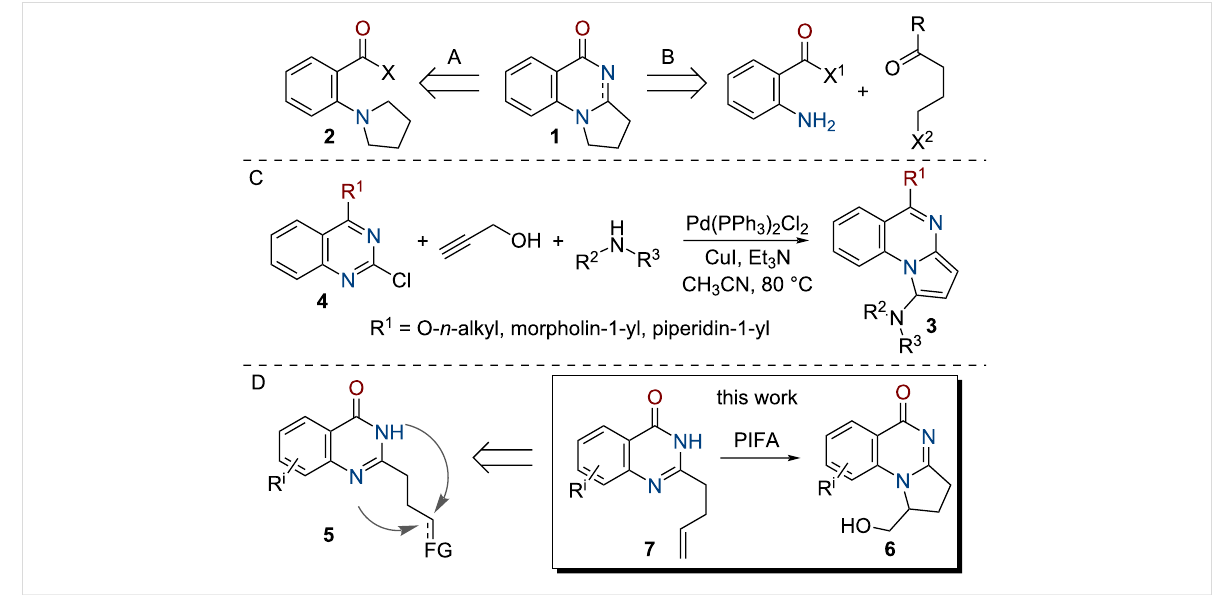
Scheme 1: Synthetic approaches to 2,3-dihydropyrrolo[1,2- a ]quinazolin-5(1 H )-one derivatives.